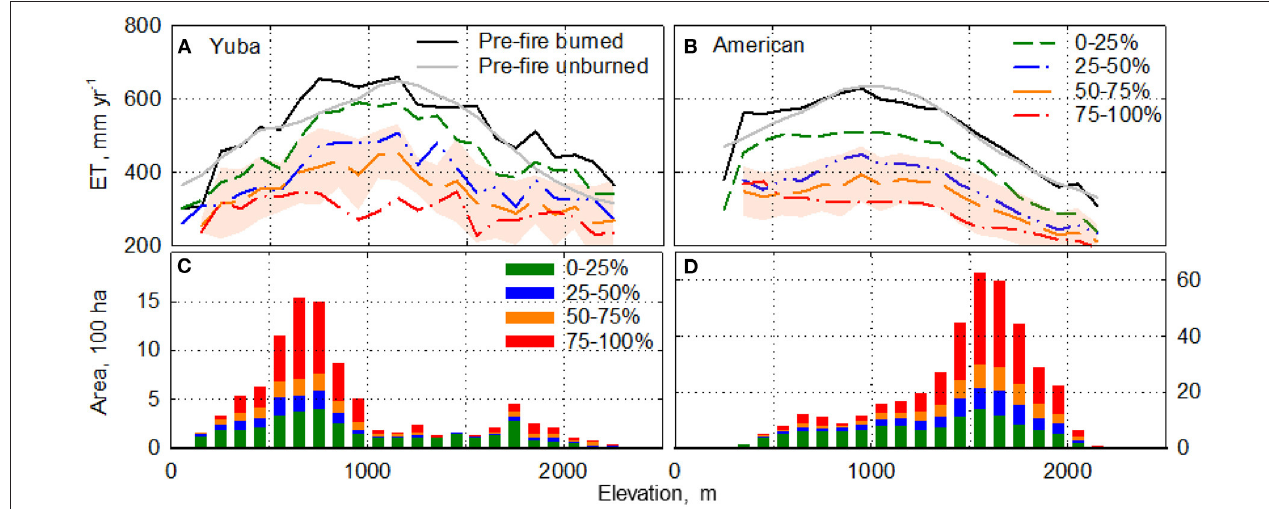
FIGURE 3 | Elevational dependence of 5-year mean evapotranspiration (ET) post-forest fire, for fires in the period 1990–2013, categorized by basal area reduction (fire-severity class): (A) Yuba and (B) American watersheds. Solid black line is pre-fire ET, and solid gray line is control (unburned) area. Shaded area illustrates the standard deviation around the 50–75% basal area reduction line. Other standard deviations are similar. Panels (C) Yuba and (D) American depict the burned area by basal area reduction quartile class (note the different ordinate scales).